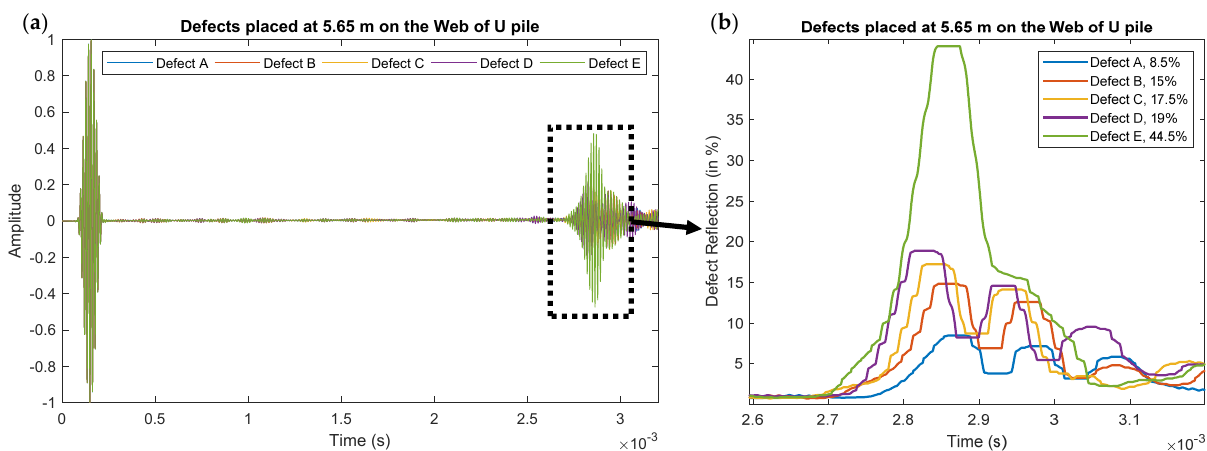
Figure 16. ( a ) Results obtained from the defects placed at 5.65 m on the web of the U-pile. ( b ) Defect reflection results from the respective defects.